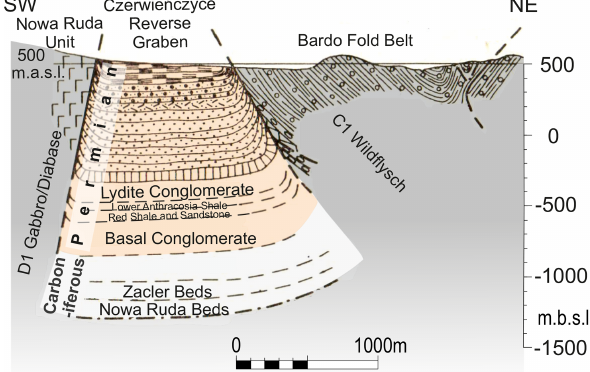
Figure 14. Geological cross-section of the Czerwie´nczyce Reverse Graben after Oberc (1972). Location in Figs. 2 and 11.